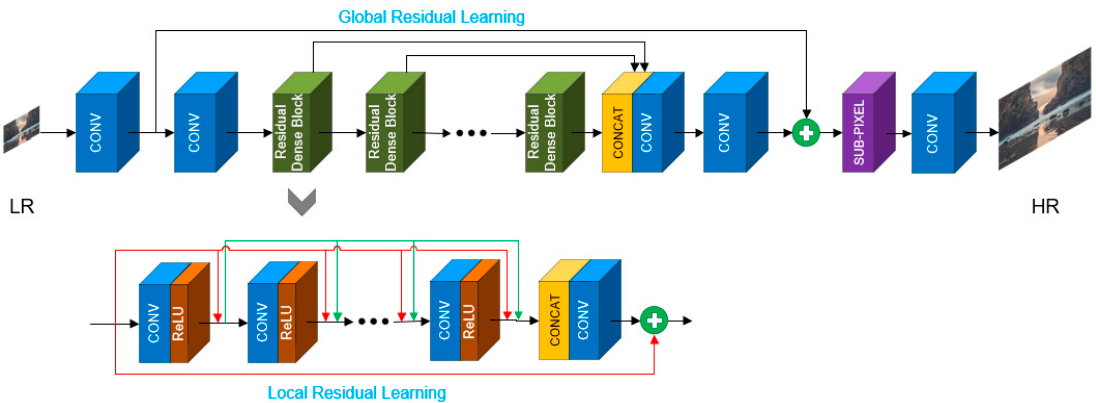
Figure 16. RDN network structure.